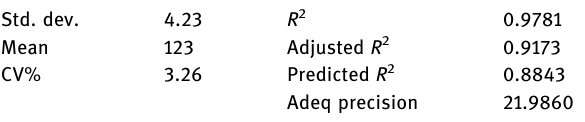
Table 16: Fit statistics for abrasion resistance